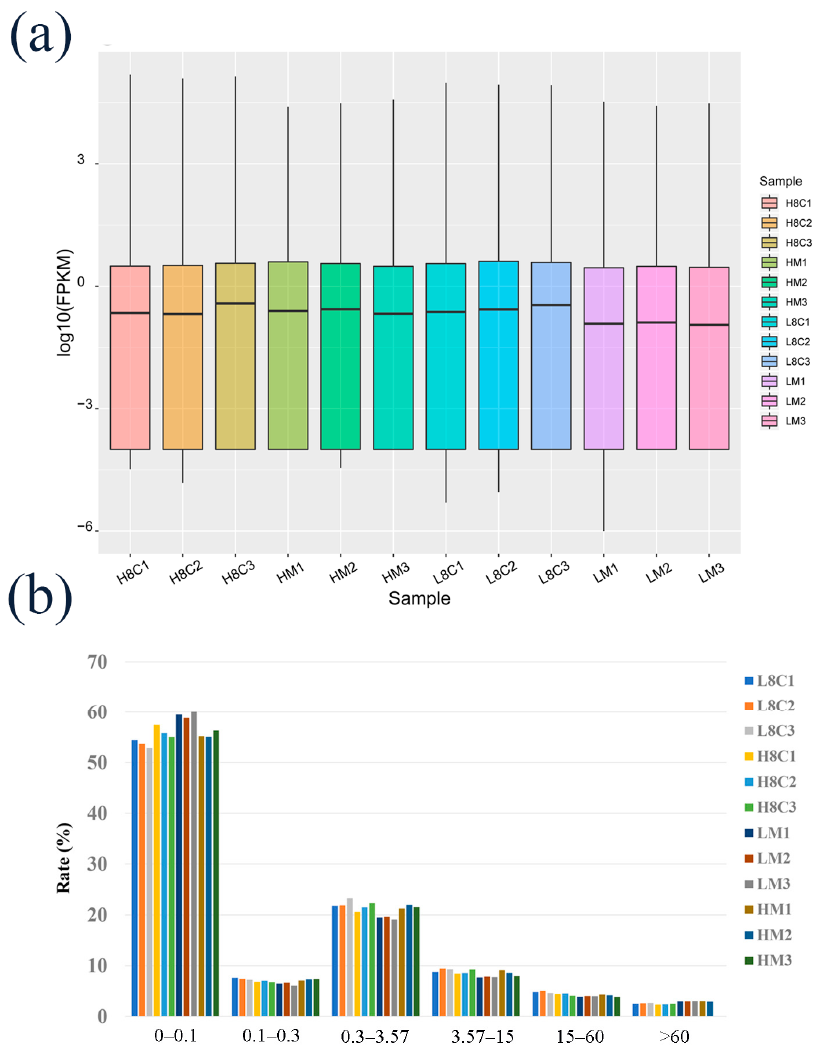
Figure 2. Genomic information on mRNA in goat embryos. ( a ) Distributions of expression values of twelve samples. The box-and-whisker plots show log10 (FPKM) of each gene from the twelve sets of RNA-Seq data. The black line in the box represents the median. ( b ) The number of detected genes with different expression levels against the range of fragments per kilobase of exon length million mapped reads (FPKM) values. Zygotes were cultured to 8-cell stage (L8C) and blastocyst stage (LM) in hypoxic conditions and to 8-cell stage (H8C) and blastocyst stage (HM) in normoxic conditions.